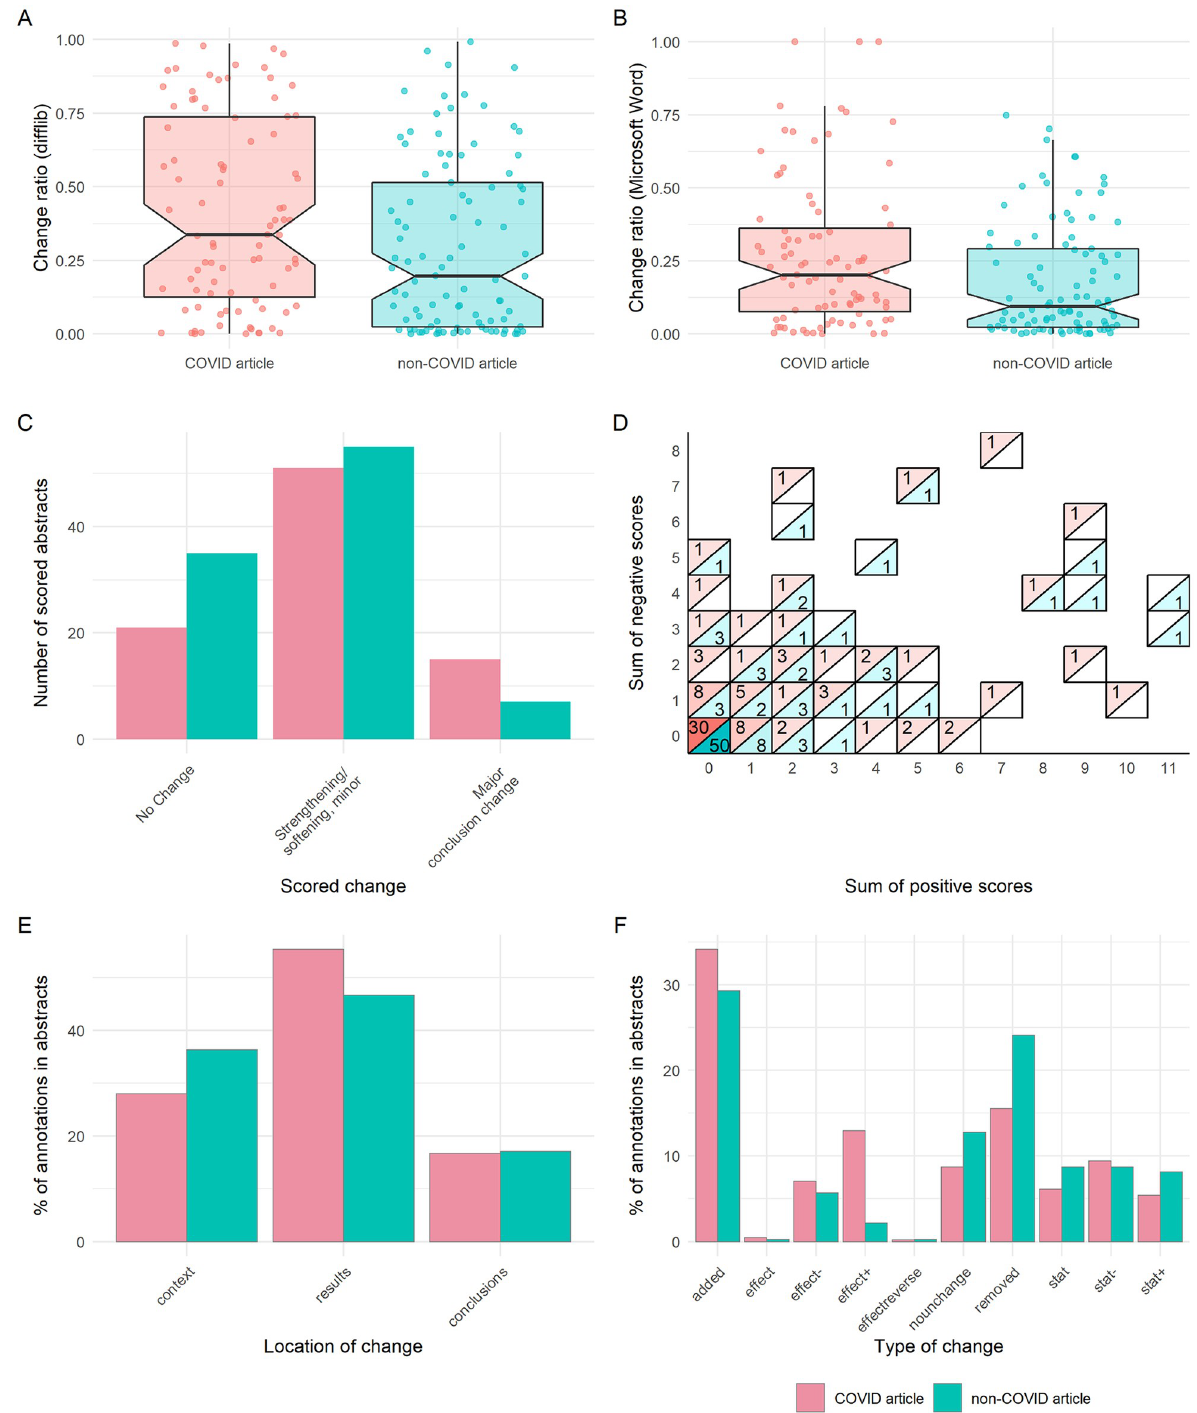
Fig 3. Preprint–publication abstract pairs have substantial differences in text, but not interpretation. (A) Difflib calculated change ratio for COVID-19 or non-COVID-19 abstracts. (B) Change ratio calculated from Microsoft Word for COVID-19 or non-COVID-19 abstracts. (C) Overall changes in abstracts for COVID-19 or non-COVID-19 abstracts. (D) Sum of positive and negative annotations for COVID-19 or non-COVID-19 abstracts, with colour and label denoting number of abstracts with each particular sum combination. (E) Location of annotations within COVID-19 or non-COVID-19 abstracts. (F) Type of annotated change within COVID-19 or non-COVID-19 abstracts. All panels describe sample of abstracts analysed in detail ( n = 184). Boxplot notches denote approximated 95% CI around medians. The data underlying this figure may be found at https://github.com/preprinting-a-pandemic/preprint_changes and https://zenodo.org/record/5594903#.YXUv9_nTUuU. CI, confidence interval; COVID-19, Coronavirus Disease 2019.